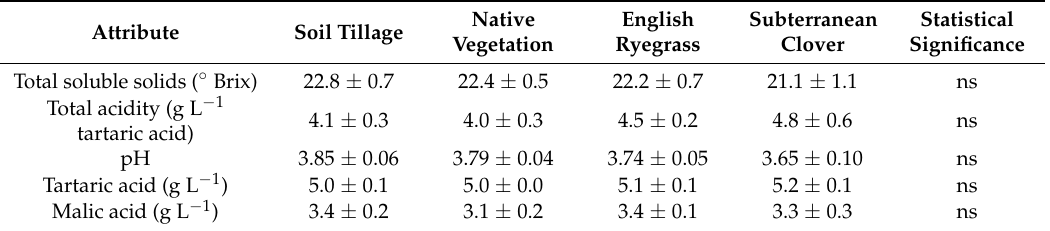
Table 1. General parameters of Menc í a musts for the different soil management treatments averaged for three seasons (2012–2014). Data are averages ± standard errors.